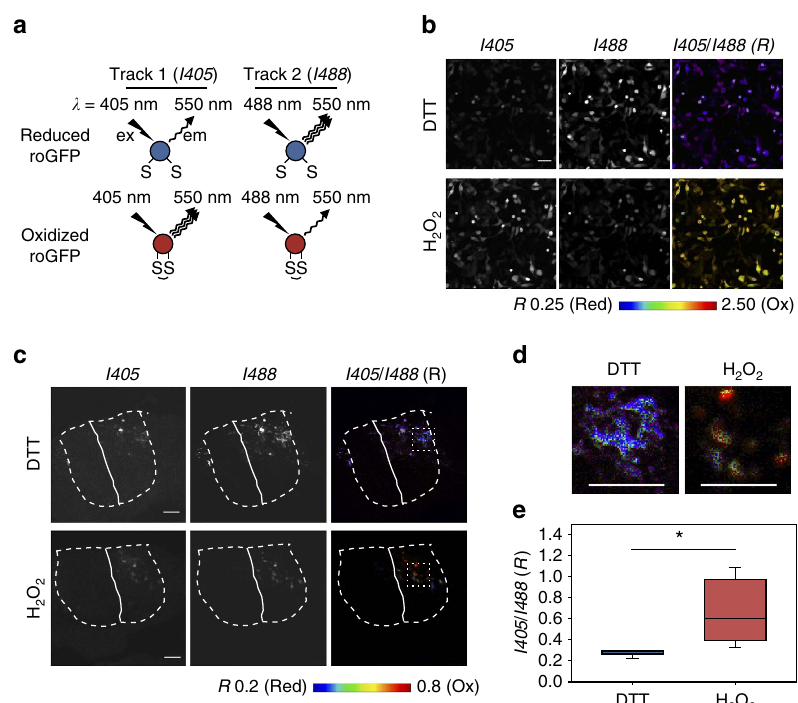
Figure 2 | In vivo measurements of the redox status of cytosolic glutathione pair in neuronal cells of chicken spinal cord using Grx1-roGFP2. ( a ) The principle of the assay using Grx1-roGFP2. ( b ) HEK293 cells were transfected with pCDNA5/Grx1-roGFP2 and the redox response was tested by sequential treatments with 500 m M H 2 O 2 and 2mM DTT. R value ( I405 / I488 ratio) is represented in a false-colour scale. Pixels with intensity higher than 127 (8-bit image) in either I405 or I488 are masked. Scale bars, 50 m m. ( c ) Grx1-roGFP2 was expressed in embryonic chick spinal cords by inovo electroporation and its redox response was verified by treating embryos with either 20mM DTTor 20mM H 2 O 2 for 10min before tissue fixation. The boundaries of the spinal cord are marked by dashed white line. The midline is marked by a solid white line. R value is shown in pseudo-colour scale. Scale bar, 50 m m. Technical details are documented in Supplementary Methods and Supplementary Figs 4–6. ( d ) Zoomed images of the areas boxed in c . Scale bar, 50 m m. ( e ) R values for multiple cells in c were measured and represented by box plots; the lower and upper boundaries of the box indicates the 25th and 75th percentiles, while whiskers and dots represent the 10th/90th and 5th/95th percentiles. A horizontal line within the box marks the median. Data are presented